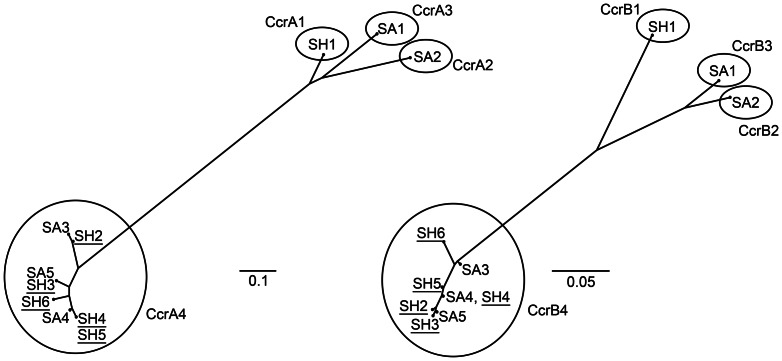
Phylogeny of CcrA4 (panel A) and CcrB4 (panel B) alleles.Translated sequences of ccrAB are from the eight S. hominis sequences obtained here (SH, underlined), along with various S. hominis (SH) and S. aureus (SA) reference sequences. Circles outline the major CcrAB alleles. Allelic variant and strain name (and GenBank accession number) are as follows: SH1 = GIFU12263 (AB063171); SH2 = DAR4404 (JQ836542); SH3 = DAR4401 (JQ836541); SH4 = DAR4386 (JQ836536), DAR4388 (JQ836537), DAR4394 (JQ836540), DAR4405 (JQ836543); SH5 = DAR4392 (JQ836539); SH6 = DAR4391 (JQ836538); SA1 = 85-2082 (AB037671); SA2 = N315 (NC_002745); SA3 = HDE288 (AF411935); SA4 = CHE482 (EF126185); SA5 = CHE482 (EF126186).